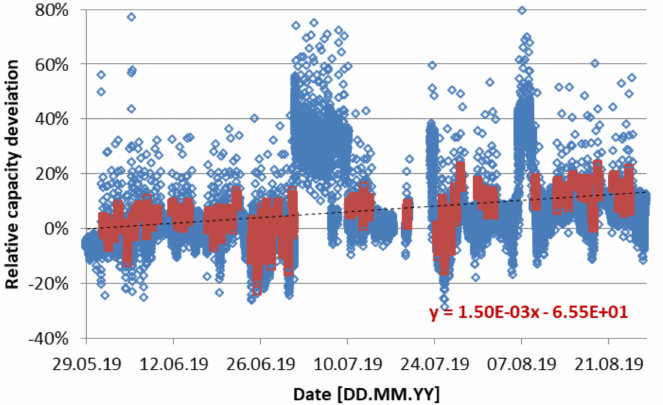
Figure 8. Trend of relative decrease of cooling tower power (calculated minus measured divided by measured) during scaling test 2 (data set Lab-Scal2); blue dots: all fan speeds; red dots: only 100% fan speed black dashed line: linear regression only 100% fan